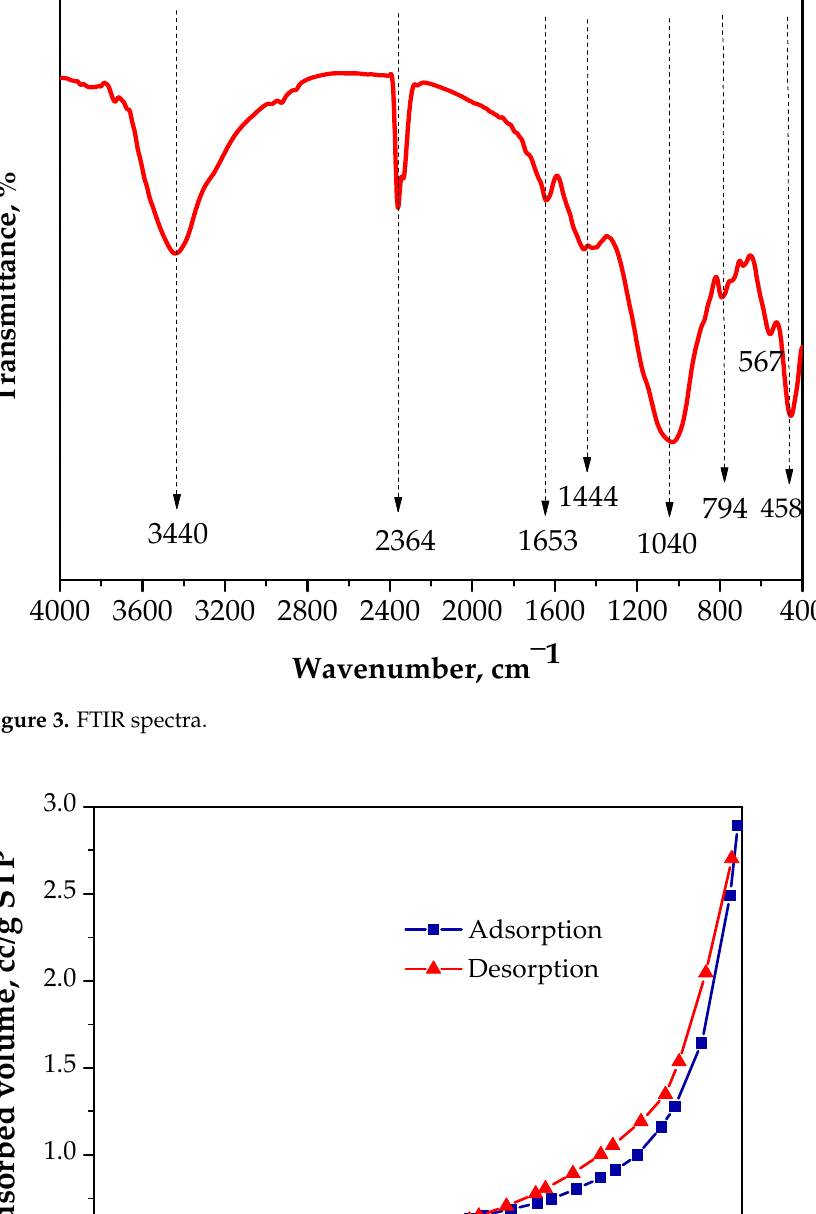
Figure 4. Figure 4. Brunauer–Emmett–Teller (BET) analysis (STP – standard temperature and pressure ab- breviation)